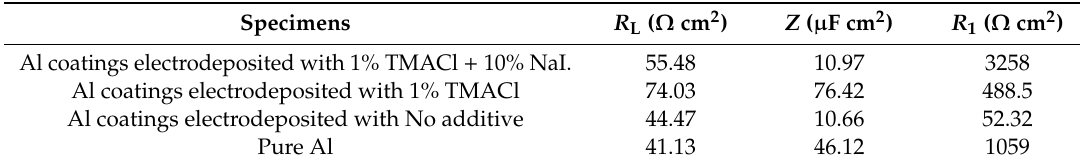
Table 3. EIS data for pure Al, Al coating electrodeposited without additive, with 1% TMACl and with 1% TMACl + 10% NaI, in 3.5% NaCl solutions.